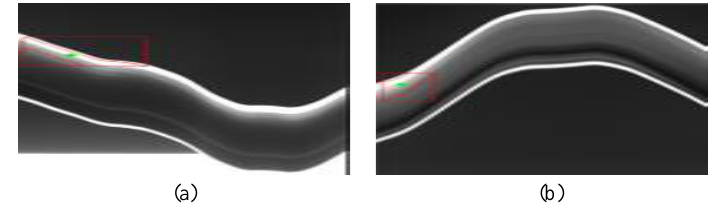
Figure 5. Position recognition of the contact wire based on the nonlinear tracking method. ( a ) The 18th frame. ( b ) The 28th frame.